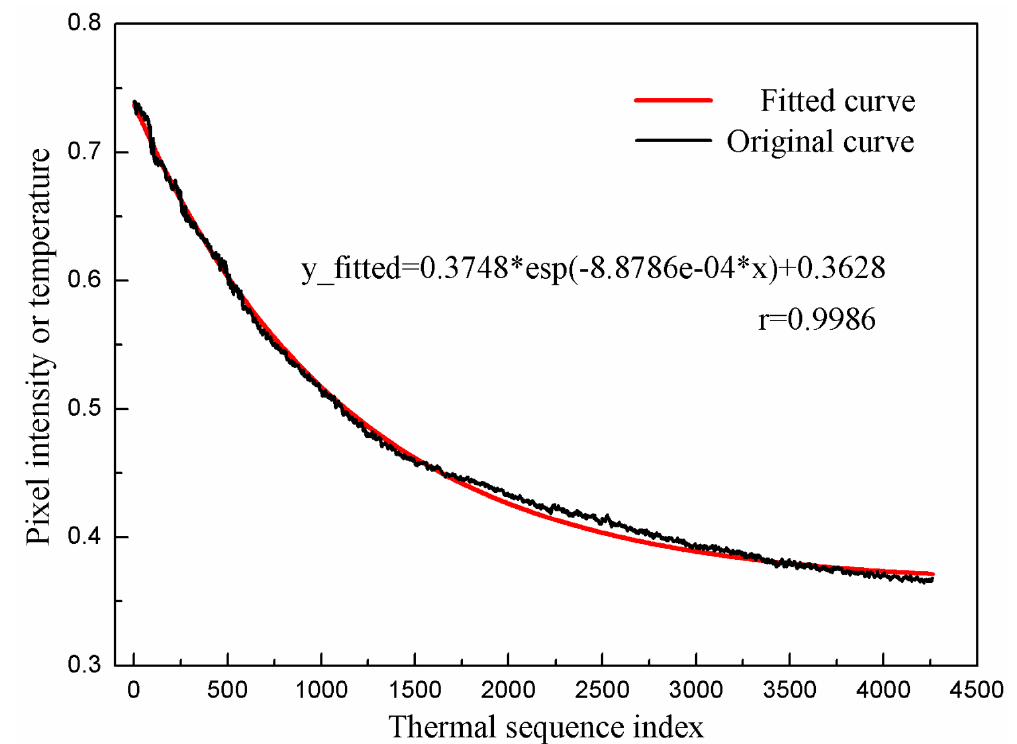
Figure 5. One typical fitting result for exponential decline phase using Newton’s Law of